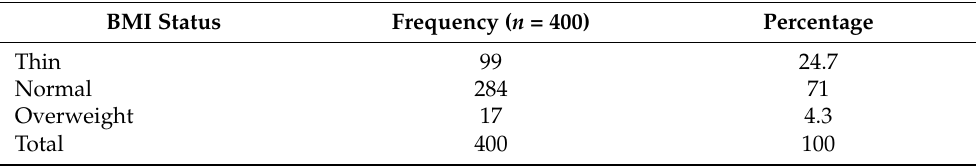
Table 1. BMI status of students.